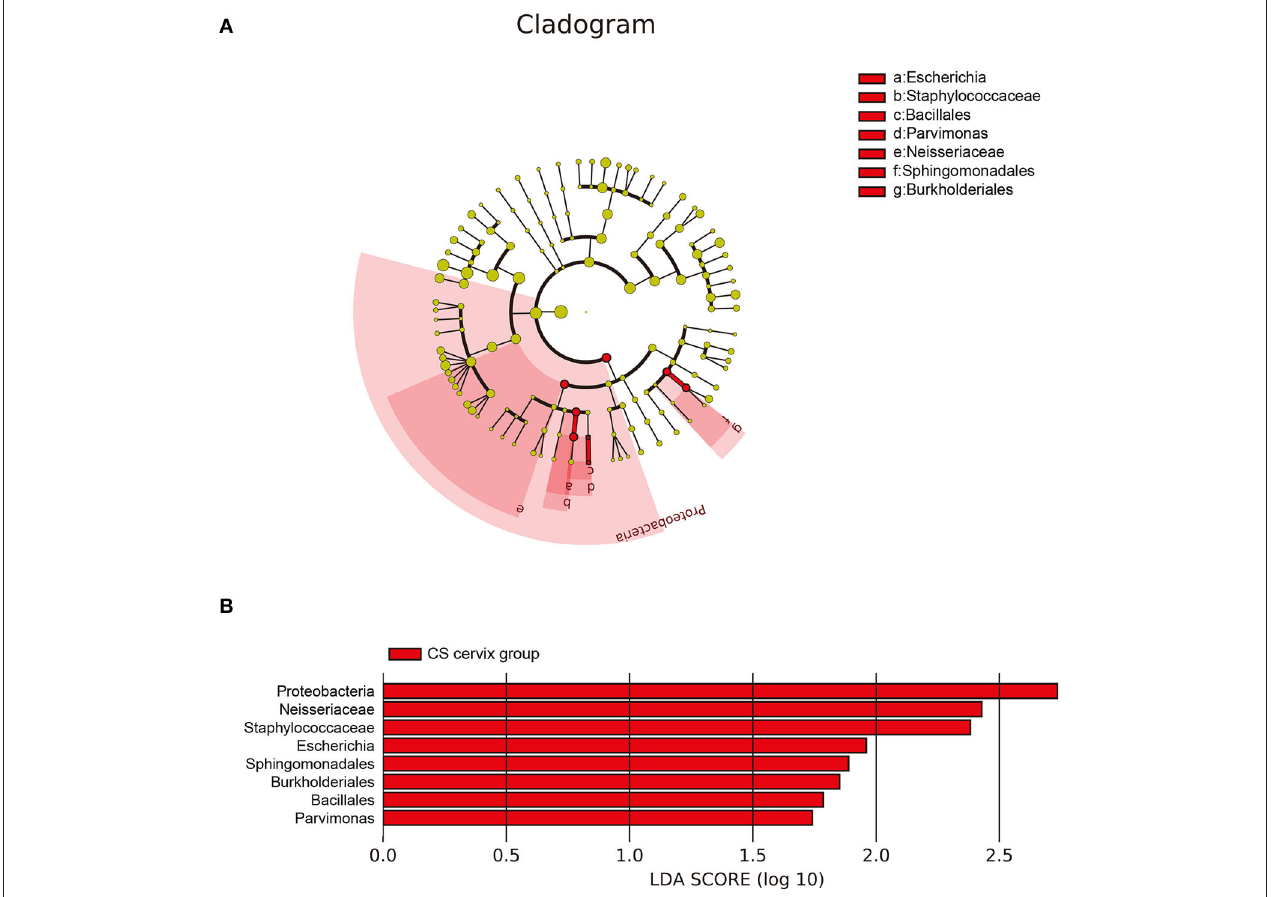
FIGURE 5 | The differences in abundance of bacteria genus among groups. (A) The LEfSe clustering tree: the different colors indicate the different groupings. The nodes of the different colors represent the microbial groups. These play an important role in the group, as represented by the color: one color circle represents a biomarker, and the upper right corner is the biomarker name. The yellow node table shows the microbial groups that do not play an important role in the different groups. (B) Proteobacteria , Neisseriaceae , and Staphylococcaceae presented with significant changes in women who underwent cesarean section, with an LDA score ranking within the top